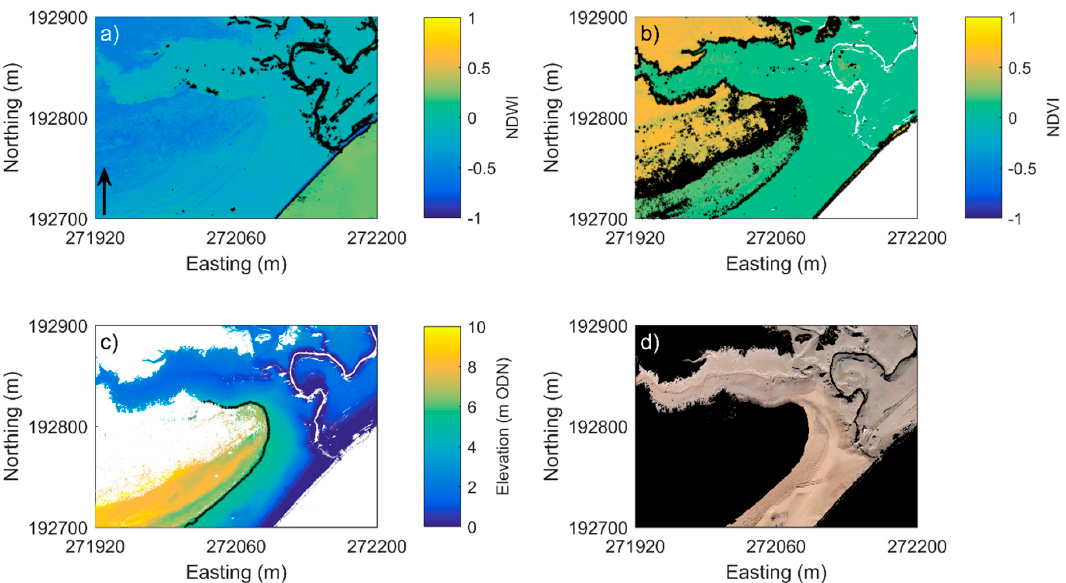
Figure 4. An example of the data screening process from the Neath estuary: ( a ) Normalized difference water index, NDWI, (color shading) and the 0 value threshold as a black contour line; ( b ) Normalized difference vegetation index, NDVI, (color shading) with NDWI removed pixels blank and the 0.3 threshold as a black contour line; ( c ) elevation (color shading) with NDVI/NDWI removed pixels blank and the HAT threshold as a black contour; ( d ) the screened orthomosaic showing the bare sediment areas after the water, vegetation and supra-tidal areas ( a – c ) had been removed. A north arrow is provided in panel ( a ). Table 2. Confusion matrix structure. Sand